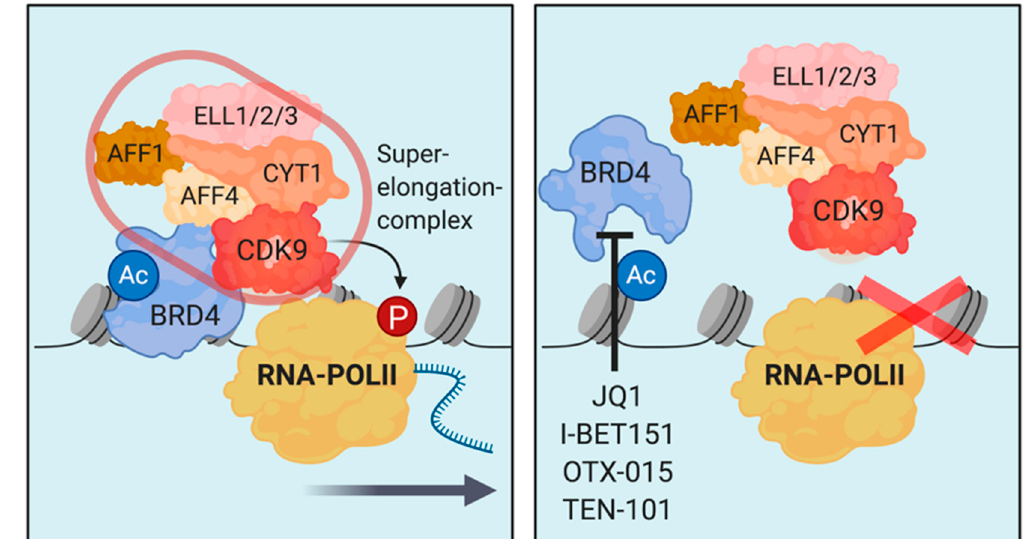
Figure 5. Illustration of the disruption of transcriptional elongation by bromodomain-inhibitors of BRD4. BRD4 binds K3K27ac and associates with the superelongation-complex (SEC) to license phosphorylation and activation of RNA-polymerase II to drive productive transcriptional elongation ( left ). Bromodomain-inhibition of BRD4 prevents binding of BRD4 to H3K27ac preventing association with the SEC and activation of transcription ( right ).